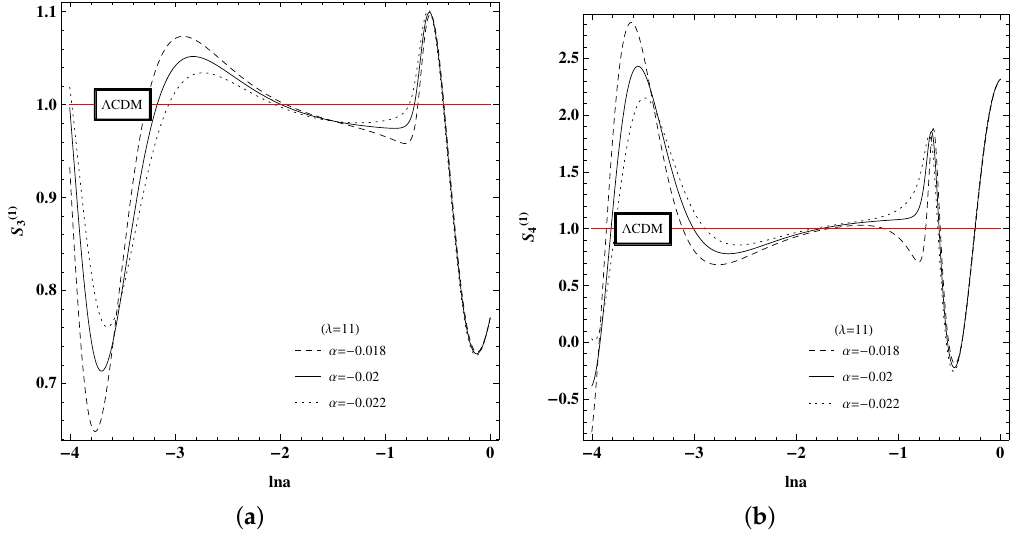
( 1 ) for P 3 with different parameters α and fixed λ = 11. ( b ) Graph of S 3